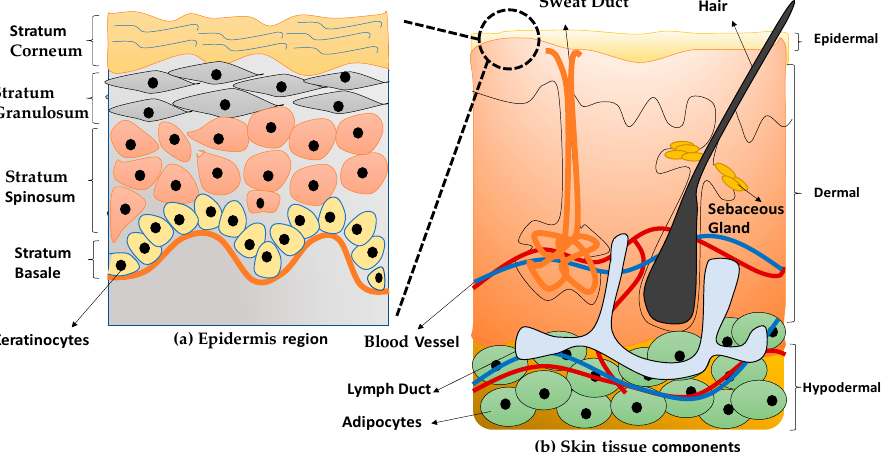
Figure 1. The anatomical structure of skin tissue ( a ) epidermis layer and ( b ) skin tissue compo- nents.